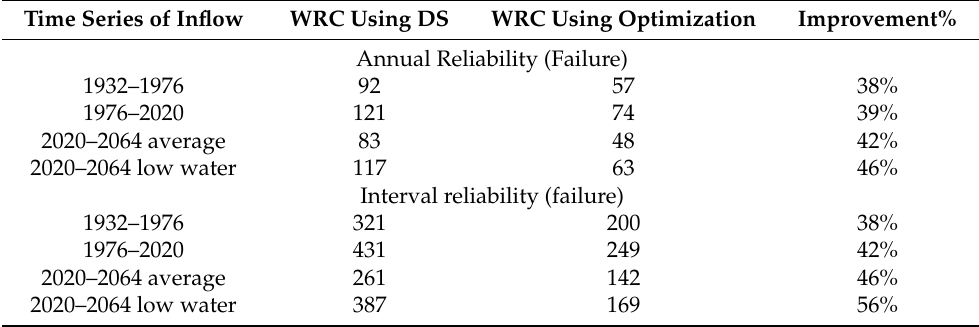
Table 1. Comparison by the sum of failures of the WRC using DS and optimization on different time series of inflow. Time Series of Inflow WRC Using DS WRC Using Optimization Improvement% Annual Reliability